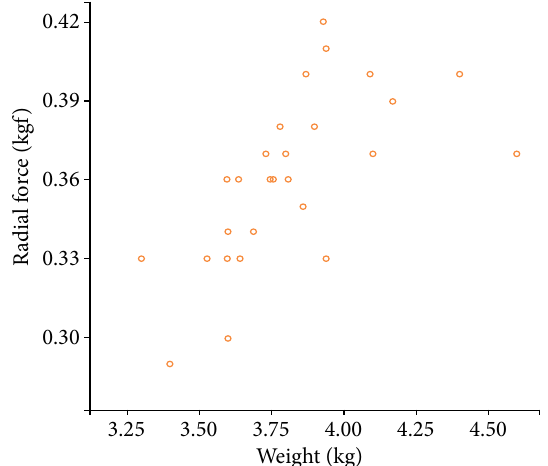
Figure 10 - Linear correlation between the tracheal radial force of the rabbits and weight. A moderate positive correlation was observed (r = 0.596, p = 0.002, and R 2 =